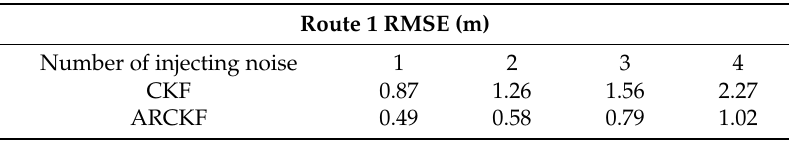
Table 4. RMSE of positioning with artificial outliers (m).